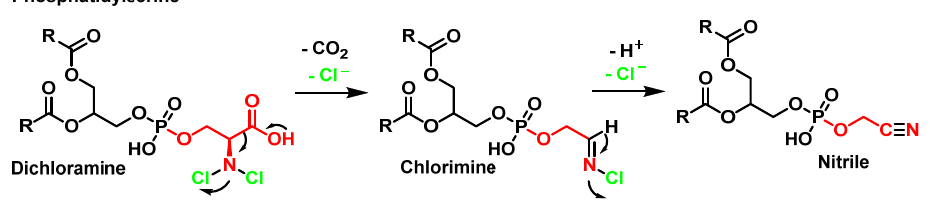
Figure 16. Decomposition of dichloroamine, formation of a transient (chloro)imine. Phosphatidylethanolamine and phosphatidylserine chloramines differ considerably